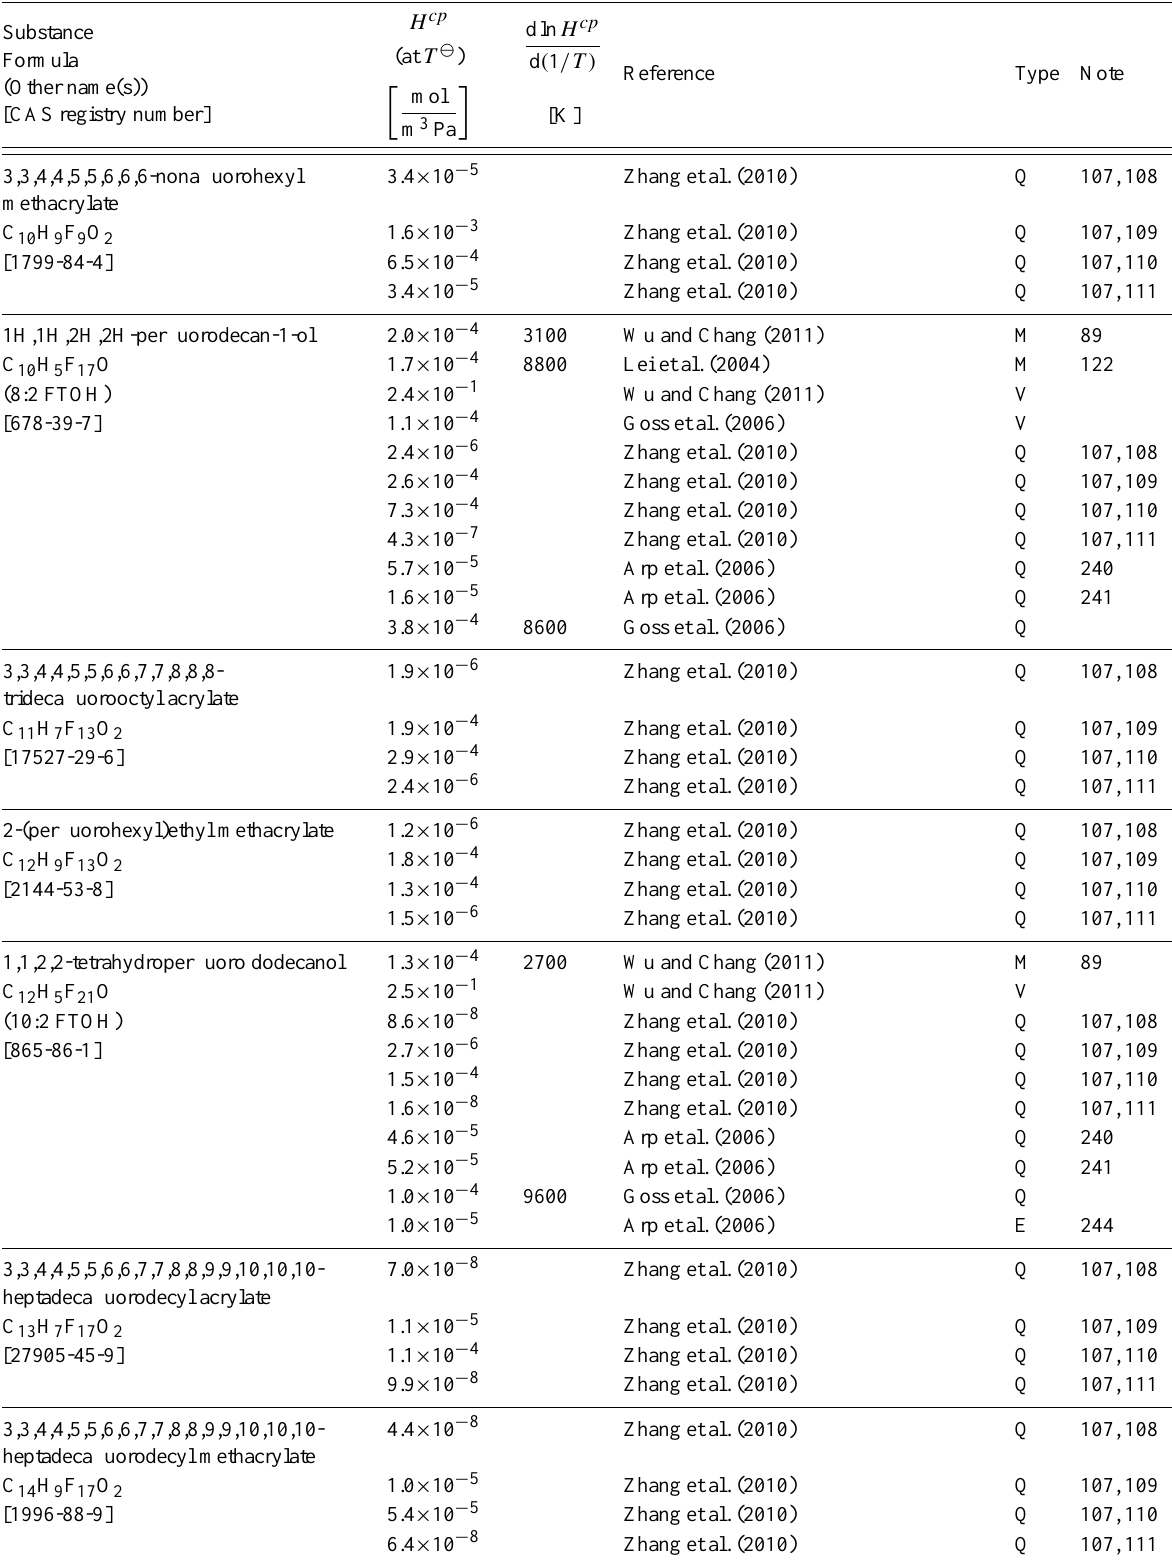
Table 6: Henry’s law constants for water as solvent